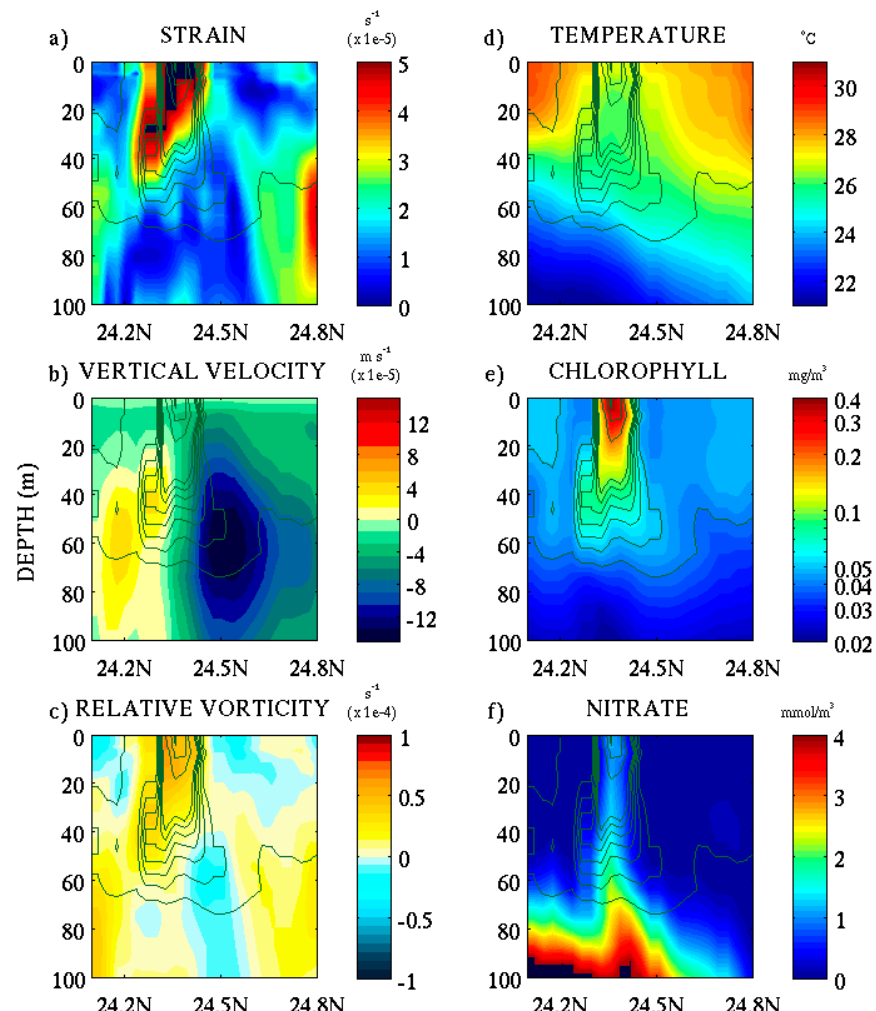
Figure 7. Simulated filament cross-section view (~88.2 ◦ W), outer filament edge 20 September 2004: ( a ) strain rate (s − 1 ); ( b ) vertical velocities (m s − 1 ); ( c ) relative vorticity (s − 1 ); ( d ) temperature ( ◦ C); ( e ) chlorophyll (mg m − 3 ); ( f ) nitrate (mmol N m − 3 ). Chlorophyll concentration contours are overlain